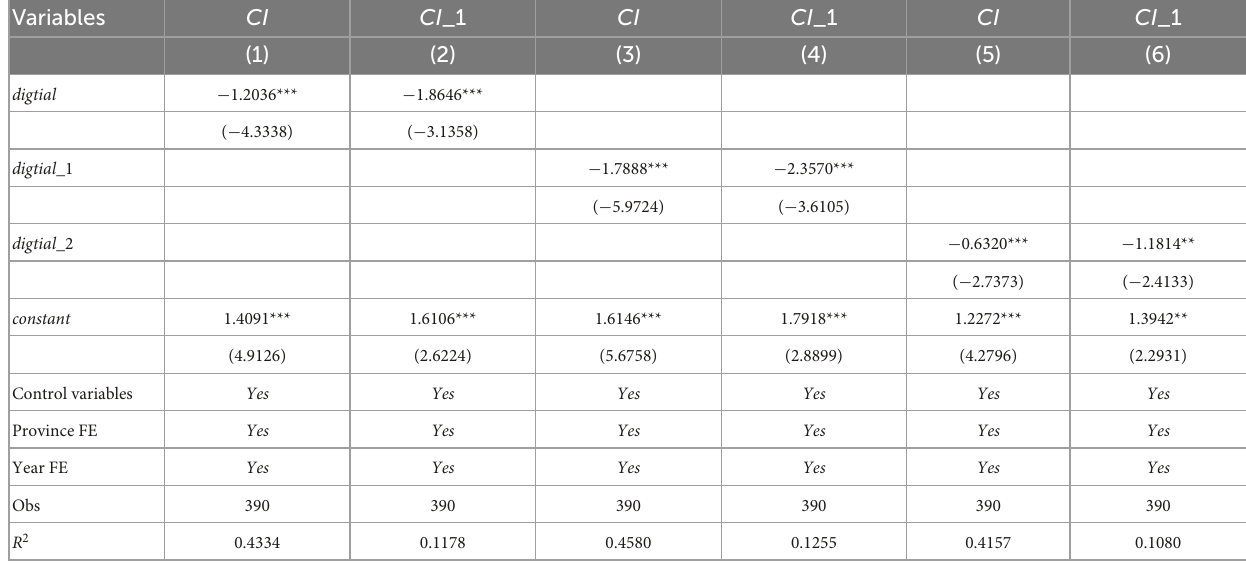
TABLE 7 Robustness test